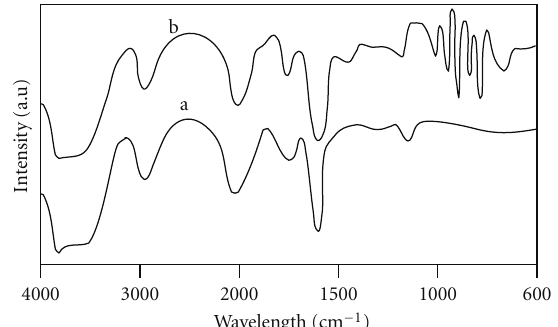
Figure 1: FTIR spectra of (a) PAN and (b) PAN/MMT (5%w/v) nanocomposite.